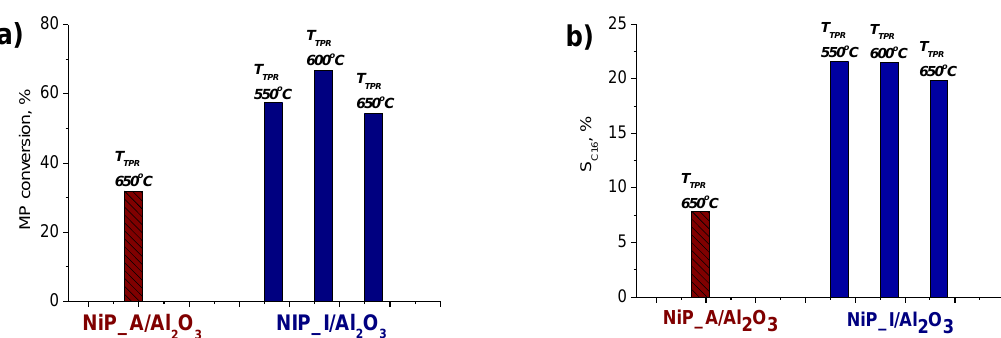
Figure 10. Conversion ( a ) and selectivity ( b ) of NiP_A/Al 2 O 3 and NiP_I/Al 2 O 3 catalysts in HDO of methyl palmitate (P H2 = 3.0 MPa, T = 290 °C, H 2 /feed = 600 Nm 3 /m 3 , methyl palmitate LHSV = 9 h −1 ).